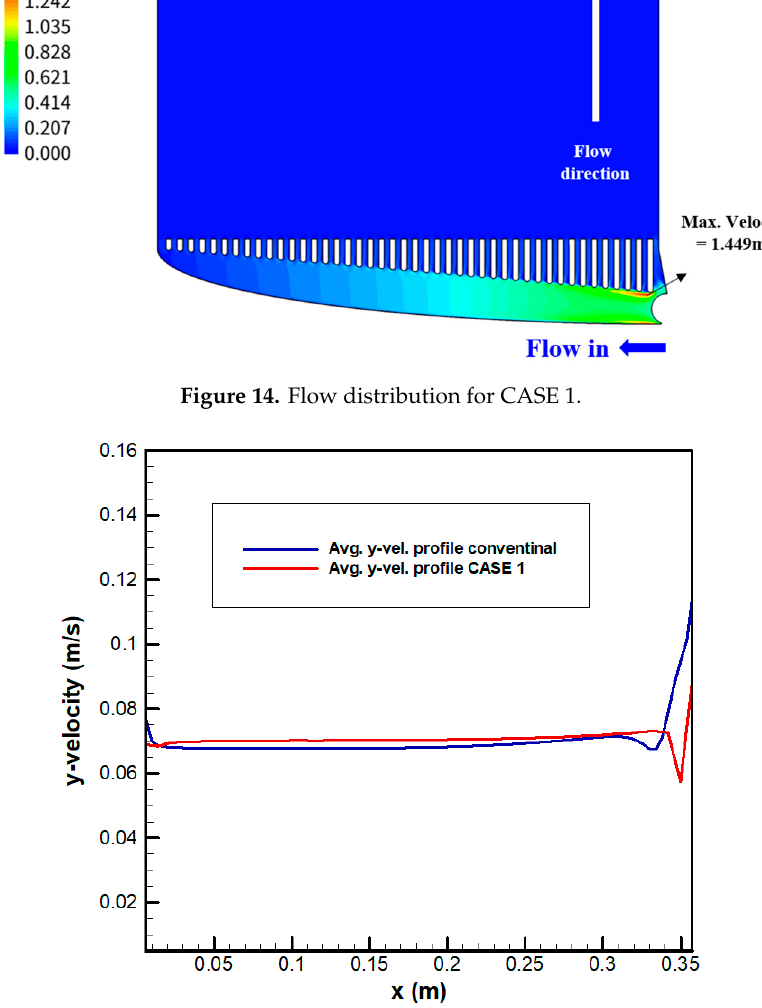
Figure 15. Velocity distribution at the electrode inlet for CASE 1 (location A). Table 6. The di ff erence in pressure drop between conventional design and CASE